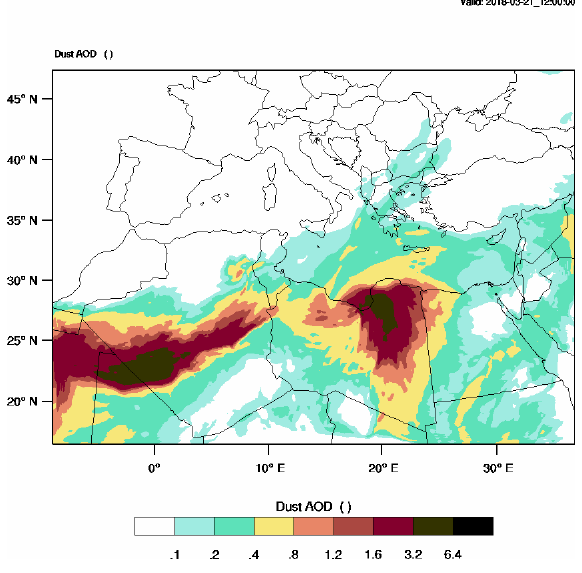
Figure 6. WRF-Chem dust aerosol optical depth (AOD) on 21 March 2018 12:00UTC.